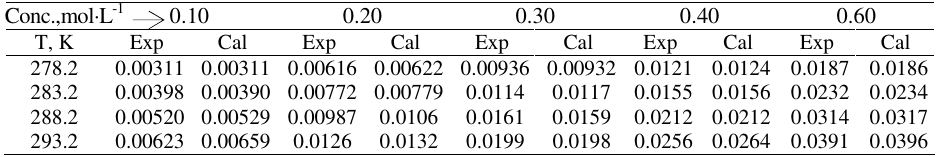
Table 2 . The values of k experimental and calculated at different temperatures ([OH - ] obs =6.76 × 10 -5 mol·L -1 R= diethanolamine) Conc.,mol·L -1 0.10 278.2